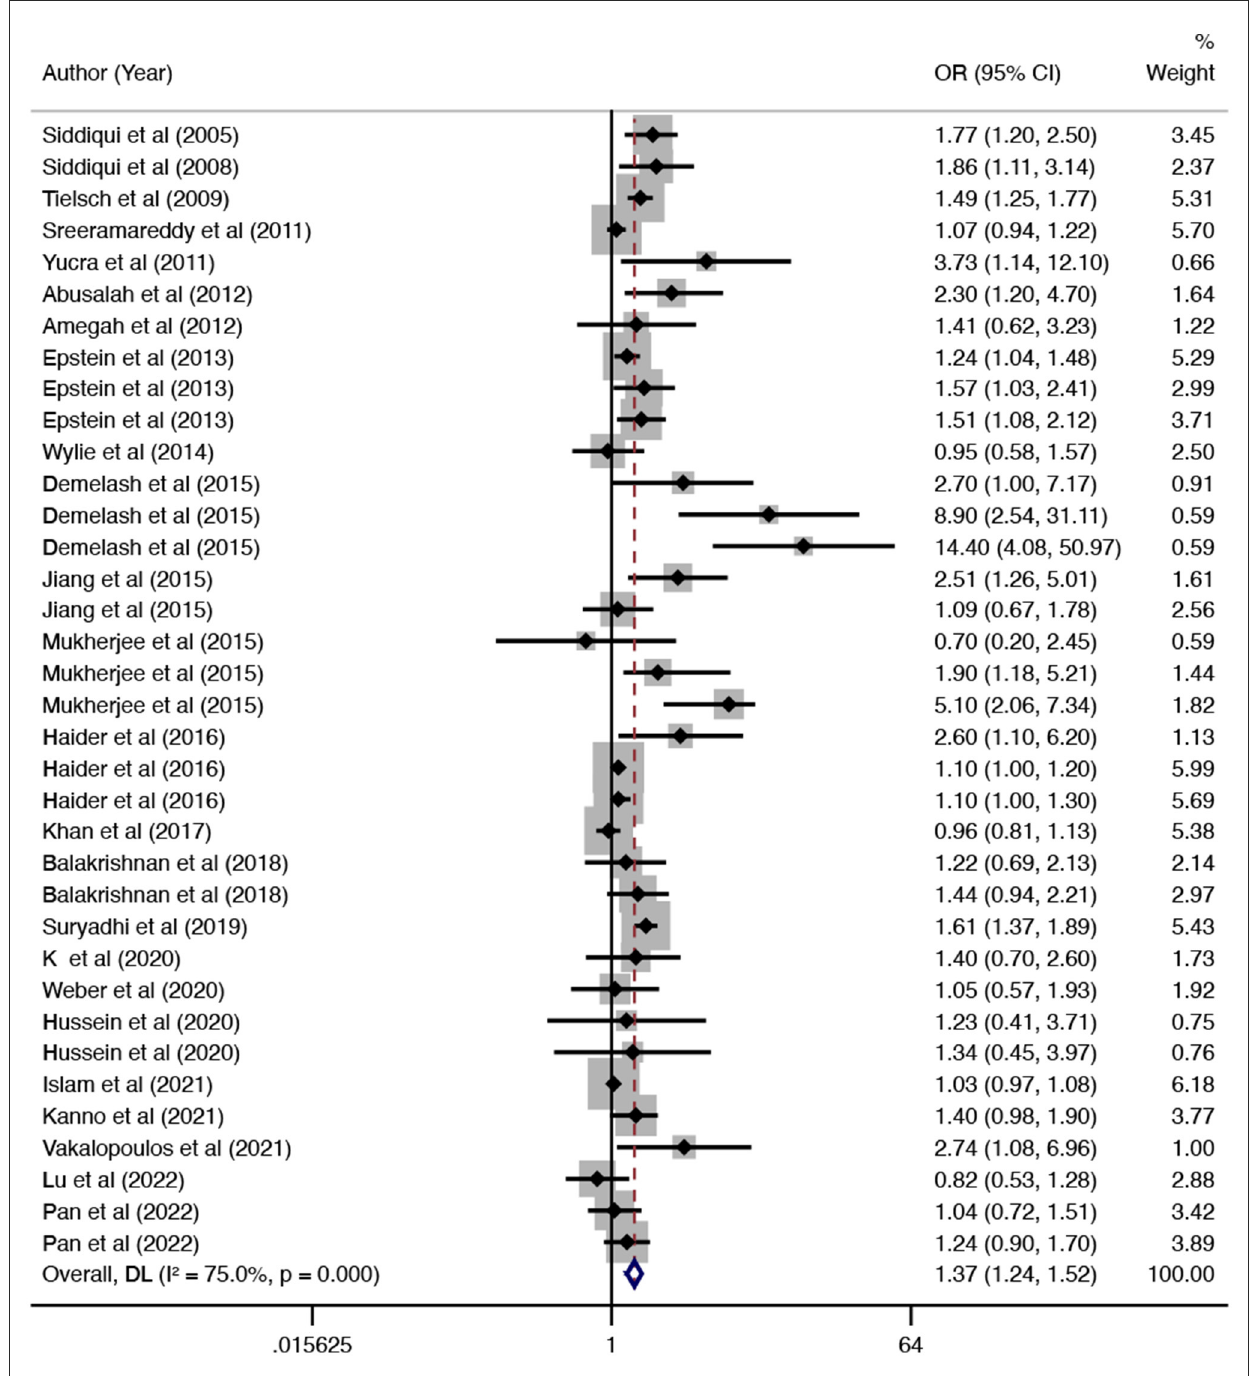
FIGURE2 Forest plot showing the effect of polluting cooking fuels on low birth weight (LBW).